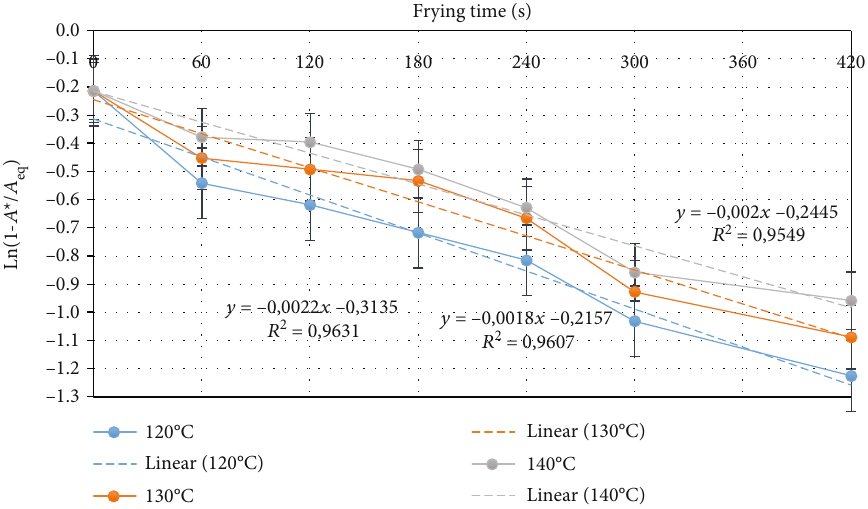
Figure 4: Linear regression of the kinetic model writes the uptake of Carimañolas during vacuum frying. Table 3: Parameters describing the oil uptake kinetics of the Coastal Carimañolas and the activation energy with Arrhenius type adjustment. Oil uptake rate Calculation of the activation energy T ( ° C)